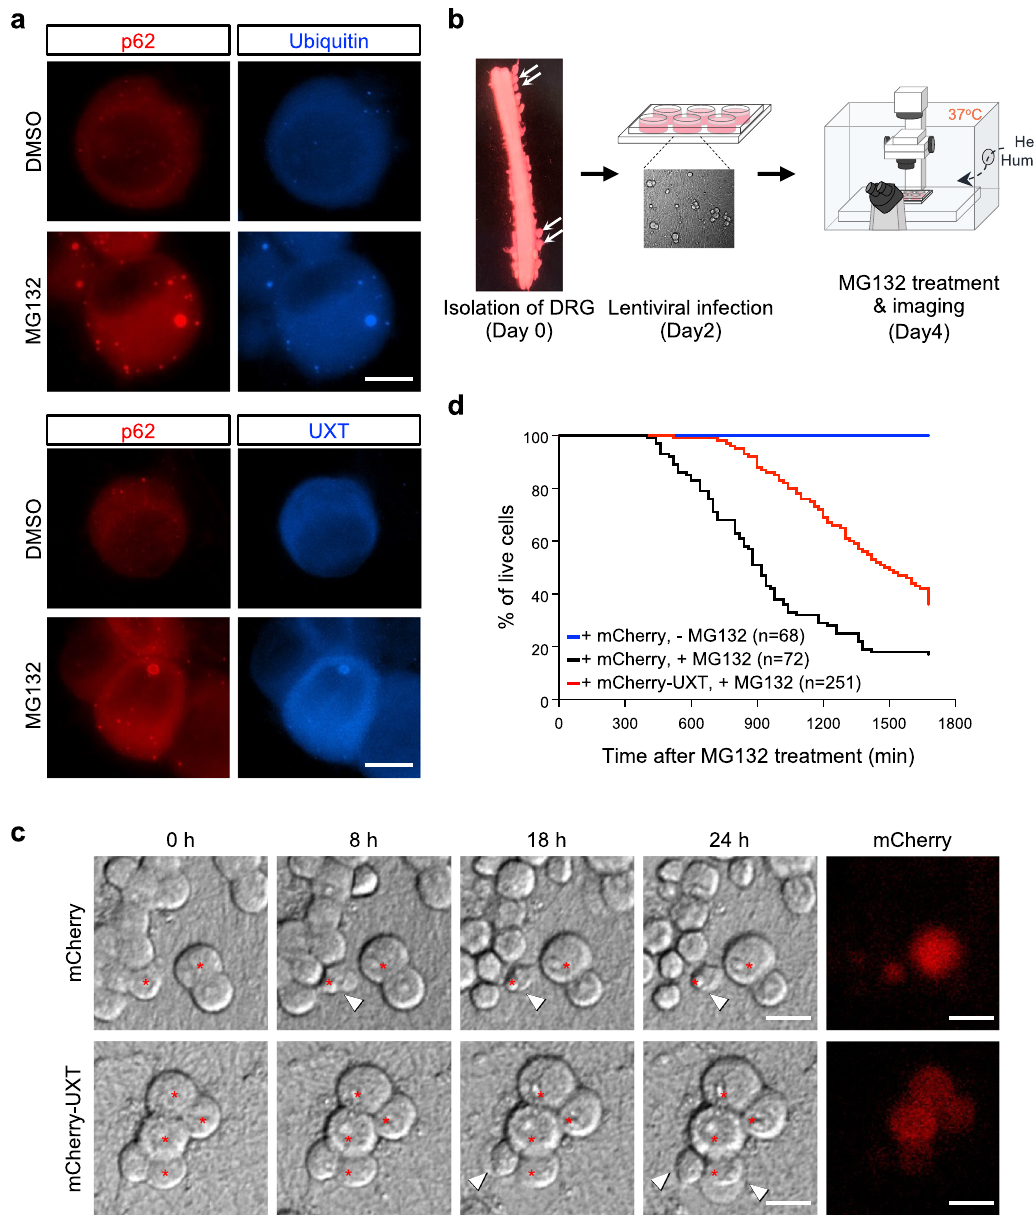
Fig. 2 UXT overexpression protects neuronal cells from proteasome inhibition-induced cell death. a Immunocytochemistry of dorsal root ganglion (DRG) neurons. DRG neurons were treated with 2.5 µ M MG132 for 12 h and compared to untreated controls. Endogenous p62 and ubiquitin-positive protein aggregates (upper panels) or p62 and UXT (lower panels) were stained under both conditions with their speci fi c primary antibodies, and subsequently with anti-rabbit IgG-TRITC and anti-mouse IgG-Alexa-350 as secondary antibodies. Scale bar, 10 µ m. b On day 0, DRG neurons (white arrows) were isolated from day 13.5 mouse embryos and cultured for 48 h. On day 2, mCherry or mCherry-UXT was introduced into DRG neurons by lentiviral transduction and cells were cultured for 2 days. On day 4, the DRG neurons were treated with 2.5 µ M MG132 and observed under a live imaging microscope with temperature and humidity control. DIC (differential interference contrast) images were collected for 28 h after MG132 treatment at 20 min intervals (Supplementary Movie 1). To identify the transduced cells, fl uorescence images were also taken at the end. c DIC images collected at 0, 8, 18, and 24h and mCherry fl uorescence images of DRG neurons are shown. Transduced cells are indicated with red asterisks. Membrane blebs are indicated with arrowheads. Scale bar, 20 µ m. d Survival of DRG neurons transduced with mCherry without MG132 treatment (blue), mCherry with MG132 treatment (black), and mCherry-UXT with MG132 treatment (red) was analyzed and is shown with the number of DRG neurons analyzed. This analysis was repeated twice with the essentially same